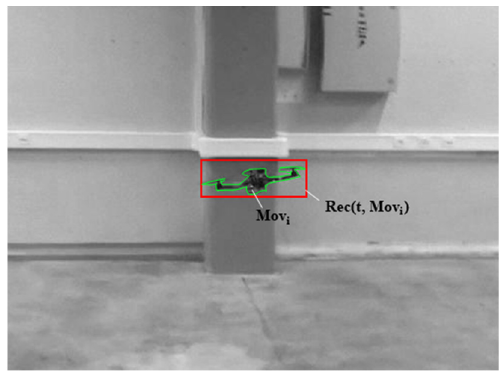
Figure 2. An illustration of a ROI. Mov i indicates the i -th extracted motion ROI, and